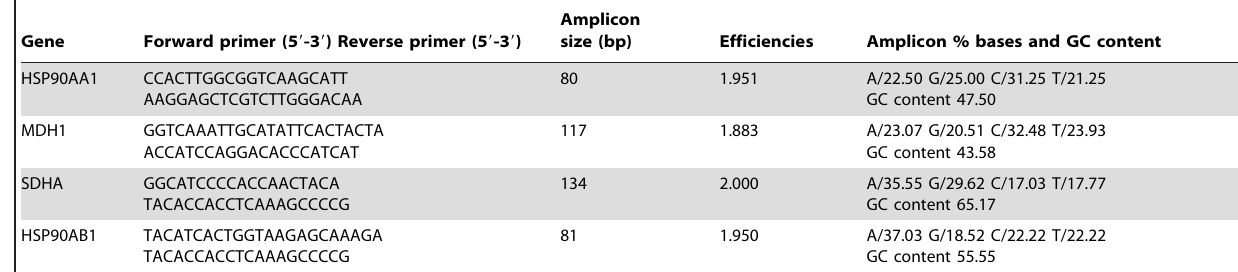
Table 3. Primers and efficiencies of the qPCR reactions.